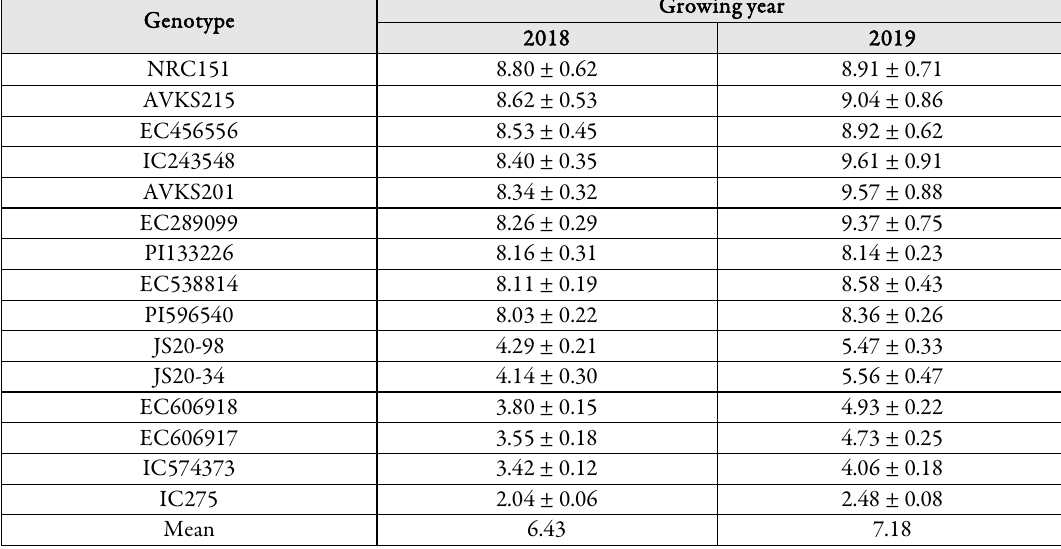
Values given are mean of triplicate samples ± standard deviation. Genotype, growing year and genotype × growing year were significant at p < 0.05 LSD= 0.49.